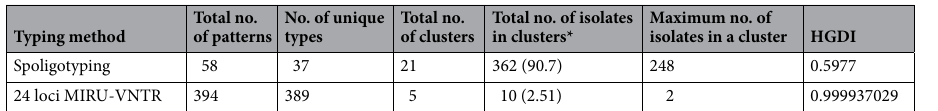
Total no. of patterns